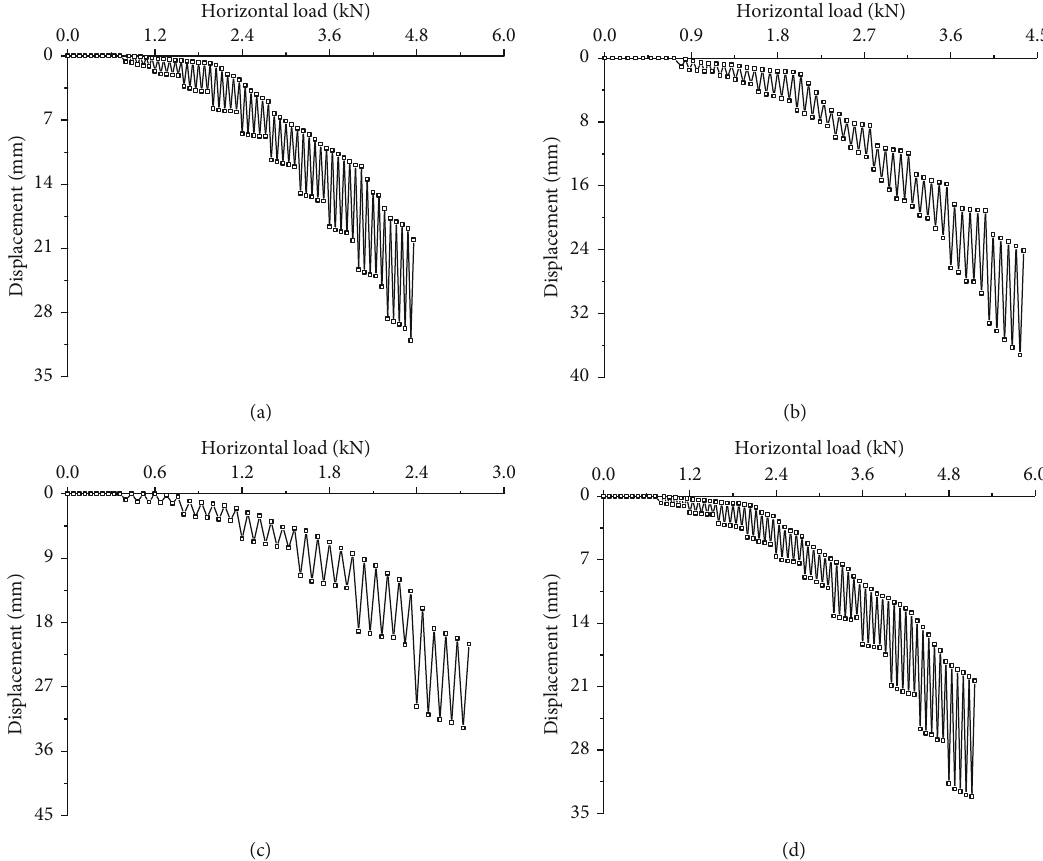
– X ): (a) Y pile; (b) Y 0 0 1